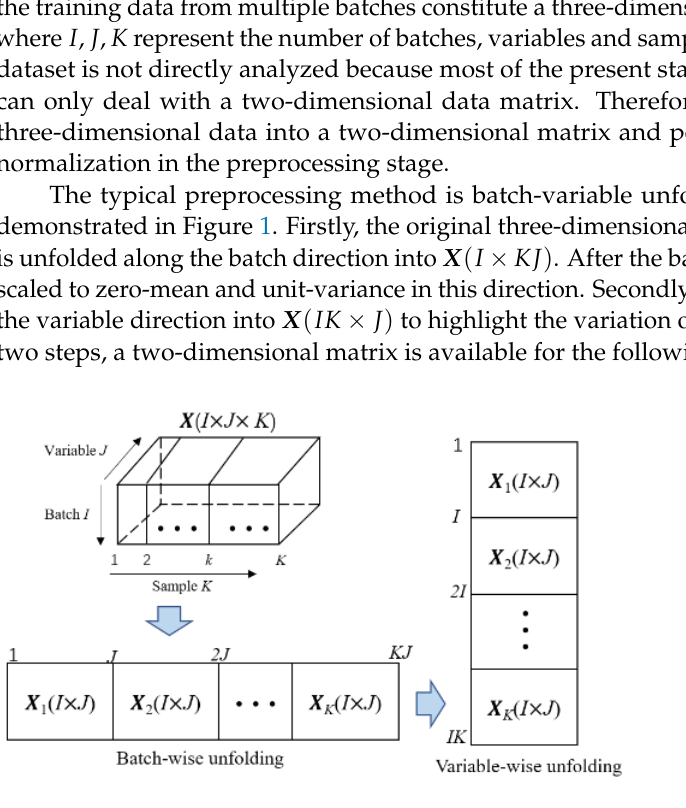
Figure 1. Batch-variable unfolding